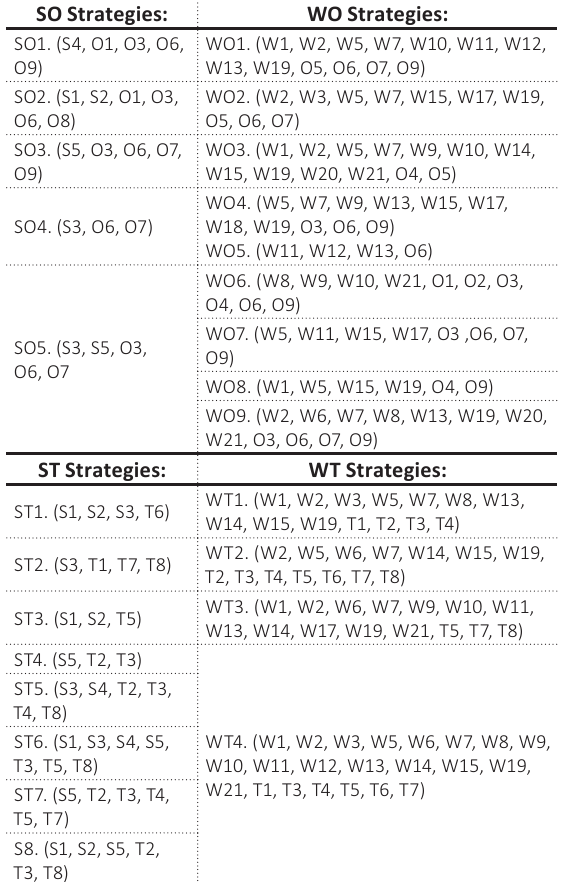
Table 4. SWOT matrix of technology transfer to the agricultural sector of Kazakhstan SO Strategies: WO